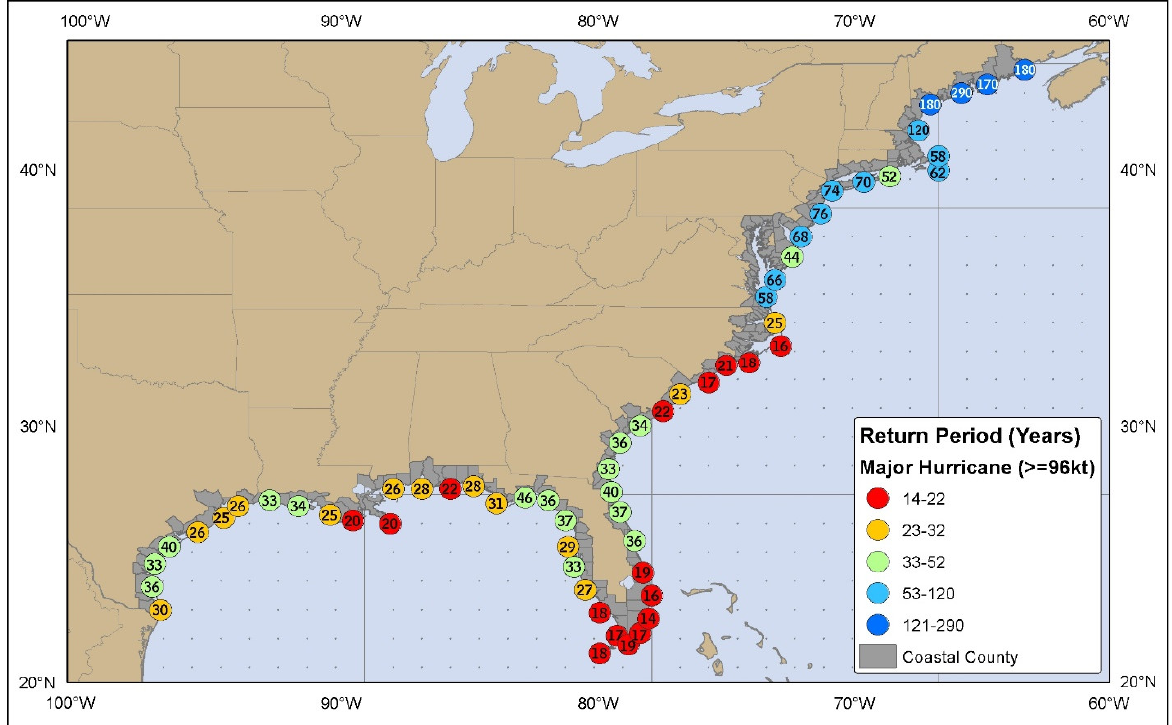
Figure 3. Return period for major hurricanes >96 kt CAT2+. Source: [12].